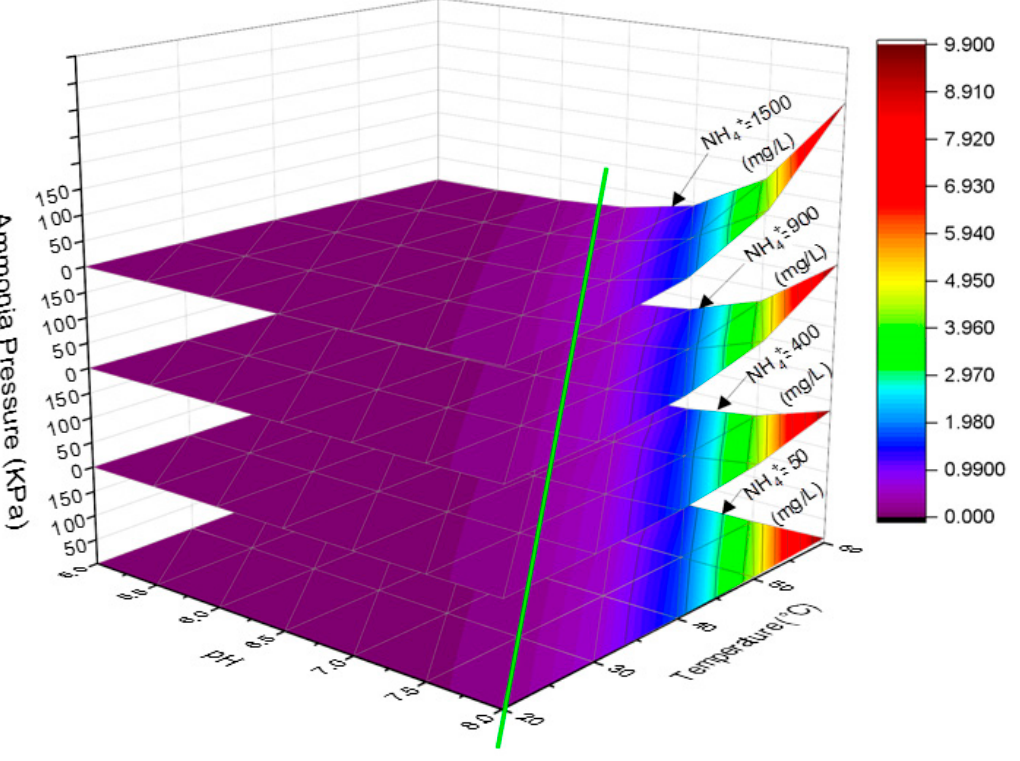
Figure 8. Ammonia pressure profiles with temperature and pH at different aqueous ammonium concentrations in